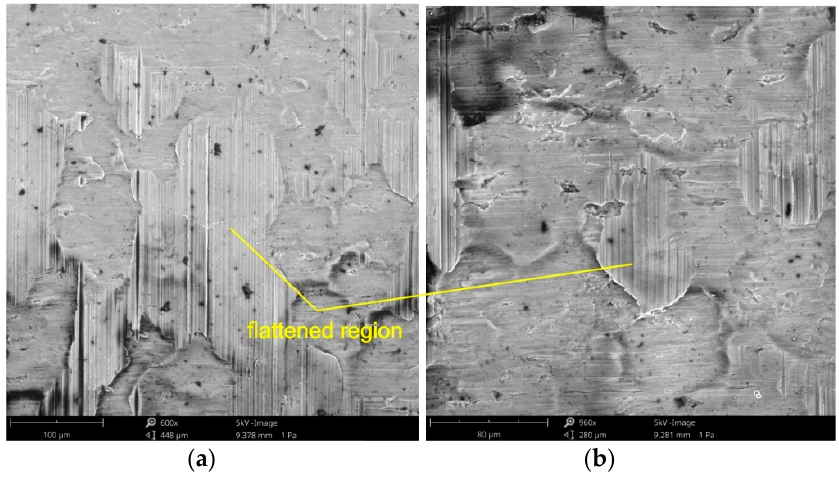
Figure 18. The specimen surfaces tested in lubricated conditions using LAN-46 machine oil (Ra = 0.32 µ m, h = 6 mm, w = 14 mm, orientation 90 ◦ ) at different magnifications: ( a ) × 600 and ( b ) × 960.